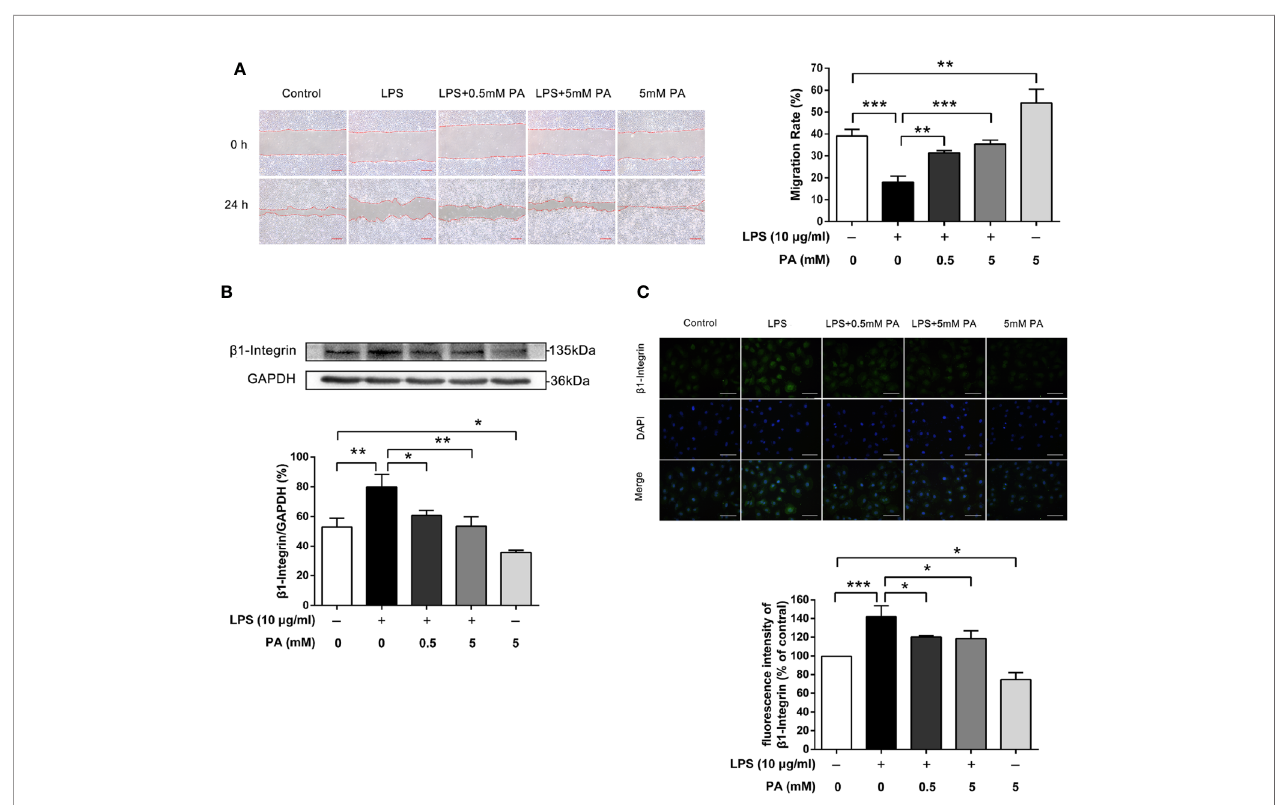
FIGURE 3 | The effects of PA on cell migration and expression of b 1-integrin protein in LPS-induced IEC-6 cells. IEC-6 cells were scrape-wounded and exposed to 0, 0.5, or 5 mM PA with or without LPS as described in Materials and Methods . (A) Images of cellular wounds generated were photographed at 0 and 24 h (scale bar: 0.3 mm). Wound healing of IEC-6 cells was assessed by comparing the wound area at 24 h after treatment with that prior to treatment. (B) The expression of b 1-integrin was examined by western blot. (C) The expression of b 1 -integrin was detected by immuno fl uorescence combined with DAPI staining for nuclei (scale bar: 50 m m). The fl uorescence intensities of NLRP3 and caspase-1 were determined using Image J software. The data in the fi gures represent the averages ± S.D. Signi fi cant differences between the treatment and control groups are indicated as *P < 0.05, **P < 0.01, ***P < 0.001. Signi fi cance was determined by one- way